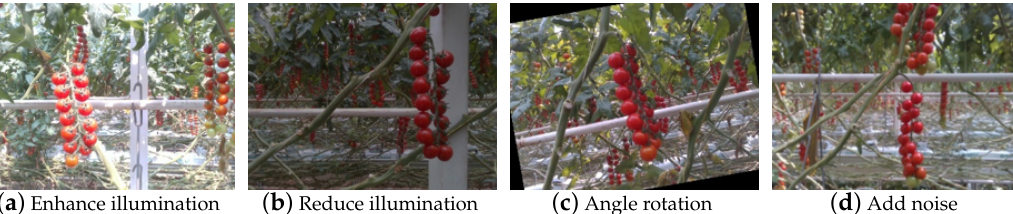
Figure 2. Images of cherry tomatoes after data augmentation: ( a ) after illumination enhancement, ( b ) after illumination reducement, ( c ) after angle rotation and ( d ) after add noise.